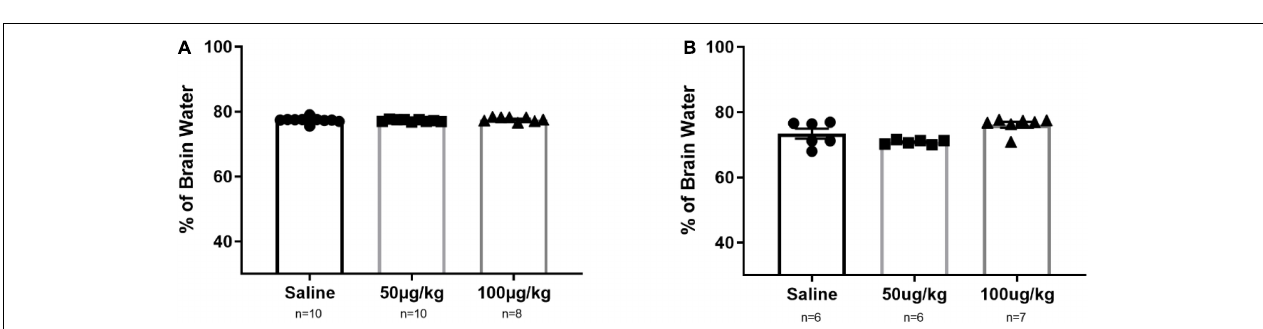
FIGURE 5 | Evaluating NG291 and 2-PAM interaction with P-gp transport. P-gp transport potential was evaluated by quantifying 3 H-verapamil accumulation in the brain in proportion to that in the perfusate. Unpaired t -test reveals p = 0.0028 in (A) and p = 0.0067 for (B) . Data are presented as mean ± SEM (control n = 9, NG291 n = 10, and 2-PAM n = 10). Post hoc power analysis was calculated with an alpha of 0.05 at 94.6% for (A) and 86.1% for (B) . ** p < 0.01.